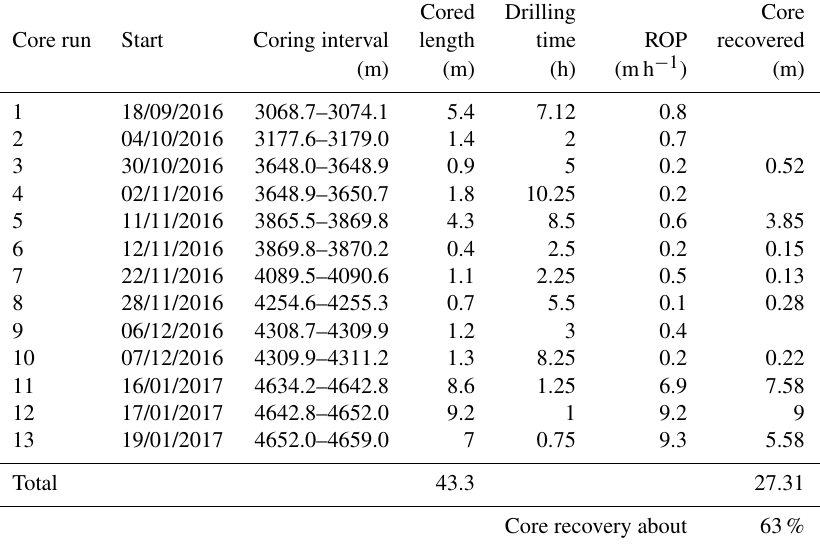
Table 2. Overview of the 13 core runs attempted in well RN-15/IDDP-2 at Reykjanes. ROP is rate of